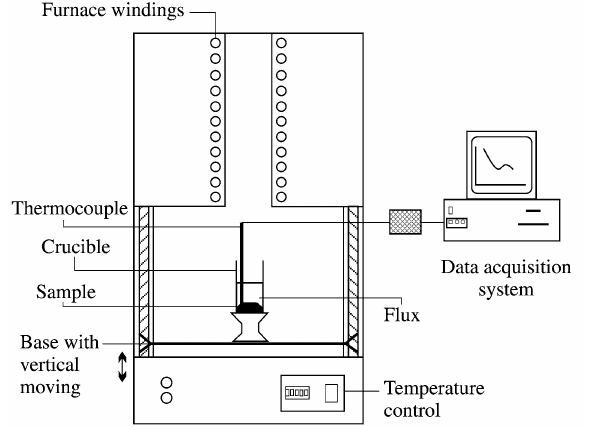
Figure 1. Experimental Table 1. Undercoolings for Pb-Sn alloys.